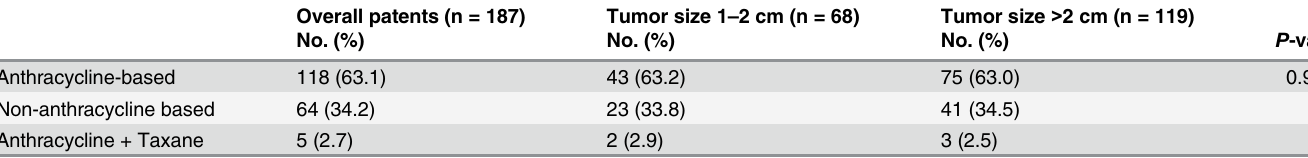
Table 2. Chemotherapy regimens for patients who received adjuvant